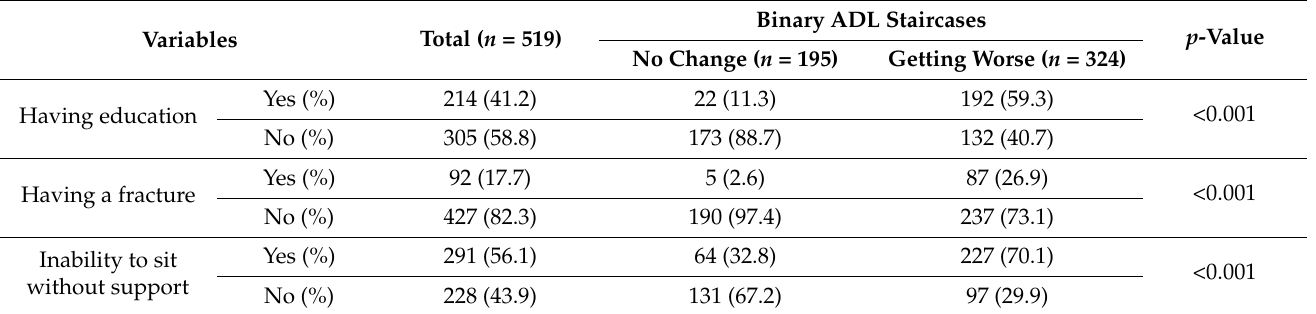
Table 3. Three predictor variables “education level”, “having a fracture”, and “inability to sit